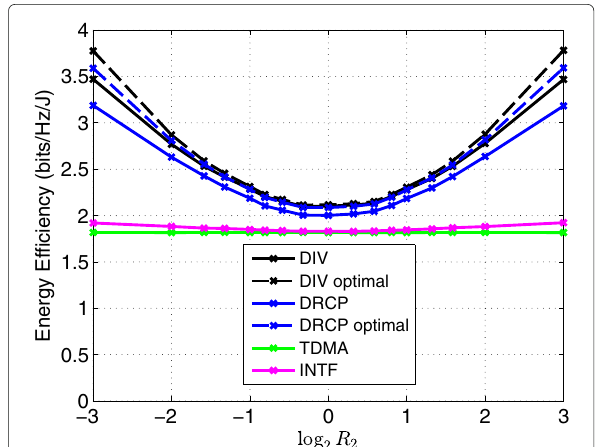
Fig. 2 Energy efficiency of the studied approaches in the transmit power-dominated regime with S min 1 = S min 1 = 0.3 bits/Hz